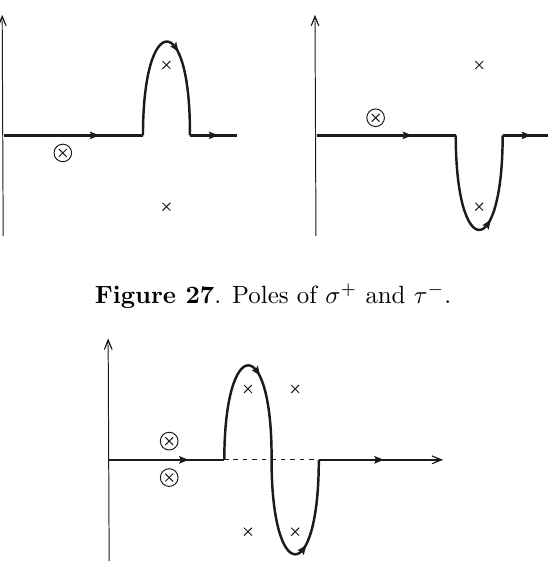
Figure 28 . Poles of the cut propagator u and LW